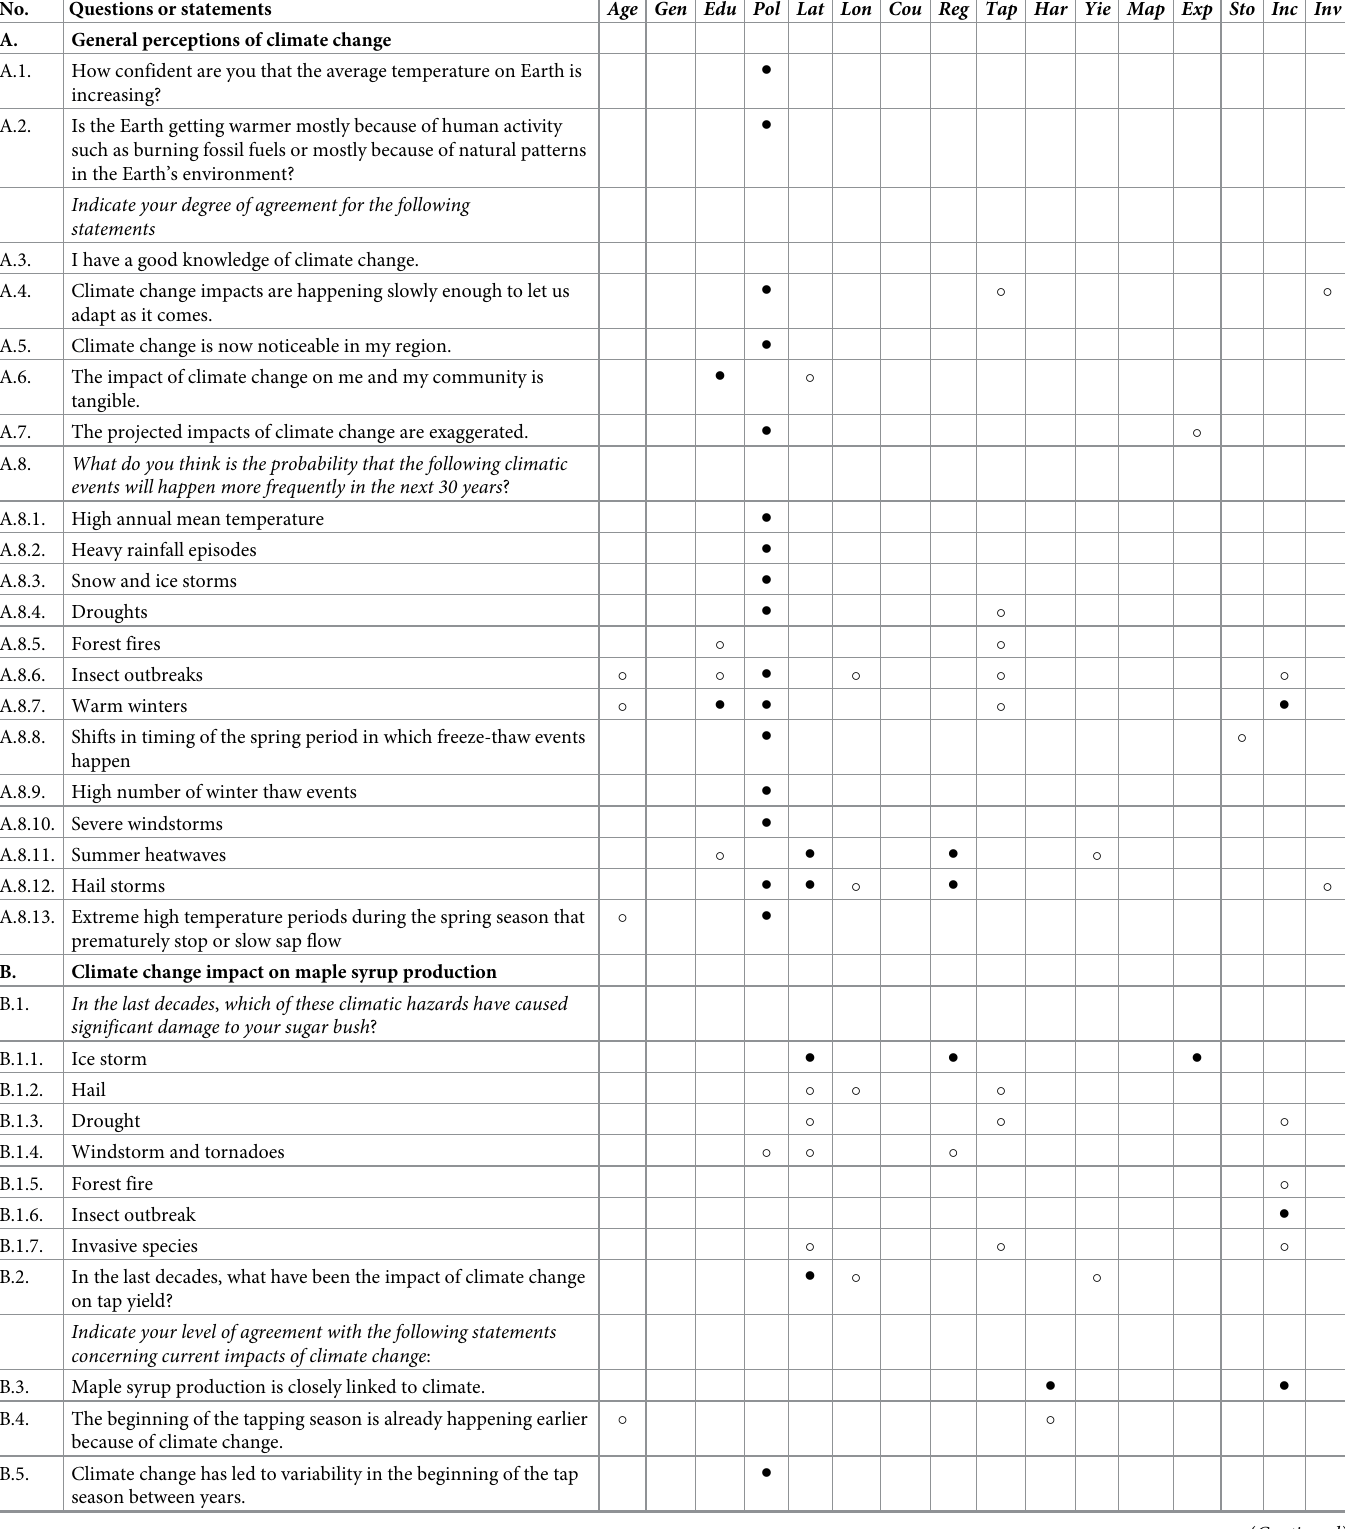
Table 3. Variables selected as potential predictors for each question or statement of the survey.